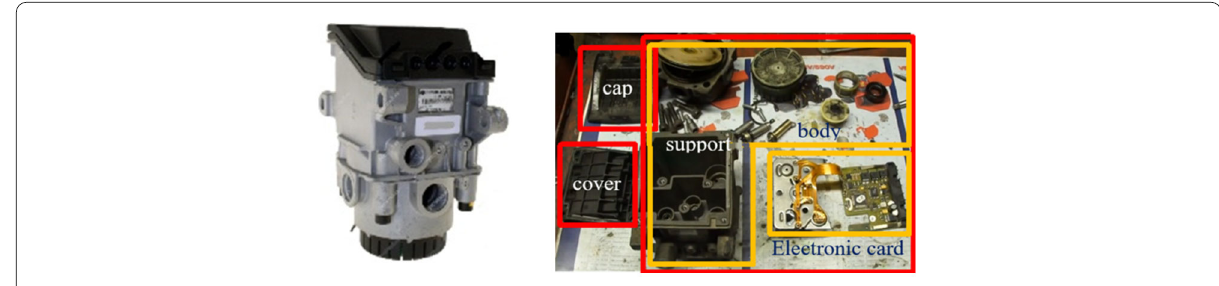
Figure 11 EBS module and components of the returned module